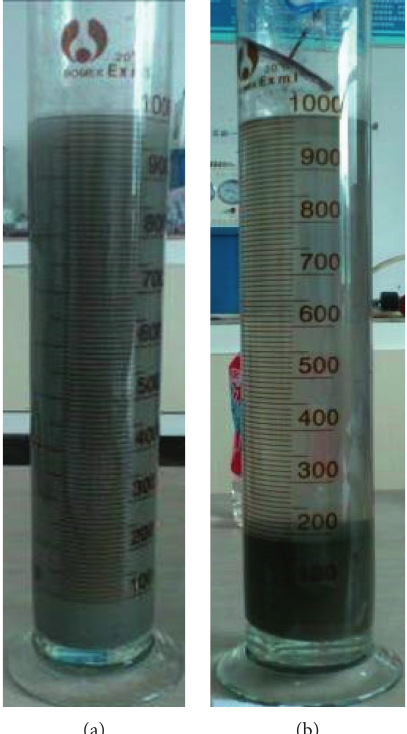
Figure 6: Photographs of (a) sample without adding lime and (b) sample with lime of 2 kg/t and APAM of 30g/t.